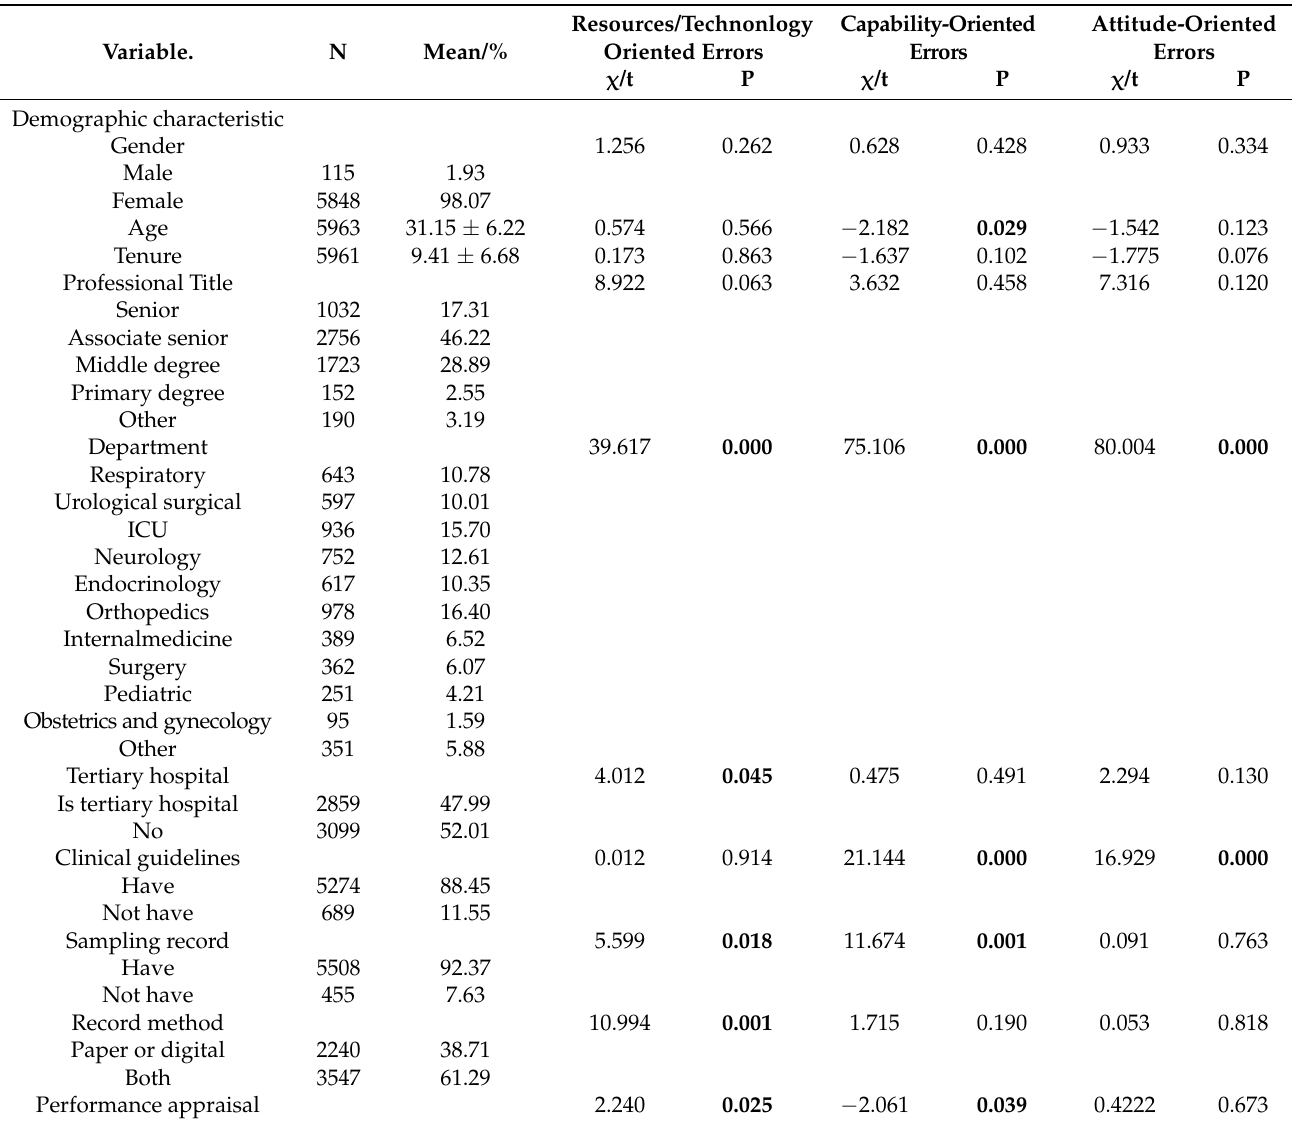
Table 1. Clinical nurses’ demographic characteristic, hospital management factors, types of sample errors, and its univariate